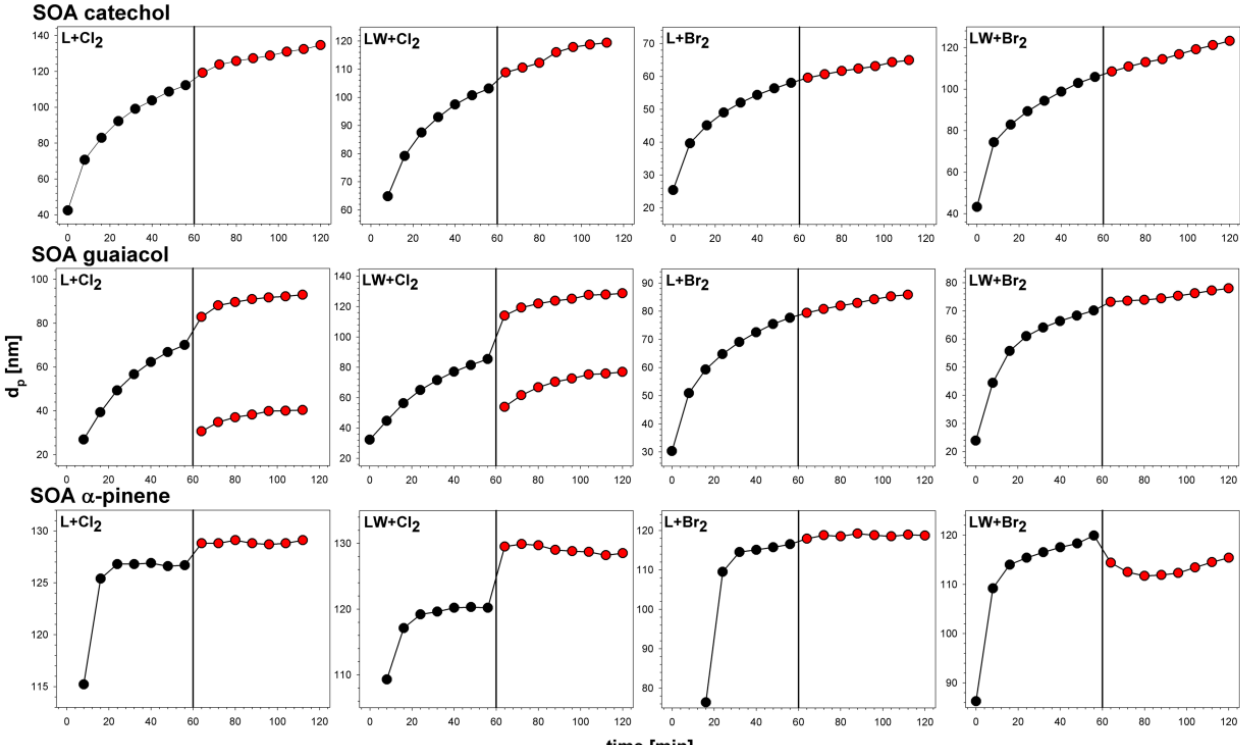
Fig. 2. Change of the mean particle diameter of organic aerosols by the reaction with gaseous halogen species for aerosol smog chamber experiments with photolyzed Cl 2 and Br 2 , respectively (L: SOA formed with simulated sunlight at 0% relative humidity; LW: SOA formed with simulated sunlight at 25% relative humidity). The injection of the molecular halogen species is marked by the vertical lines at about 60min after starting the irradiation and SOA formation.